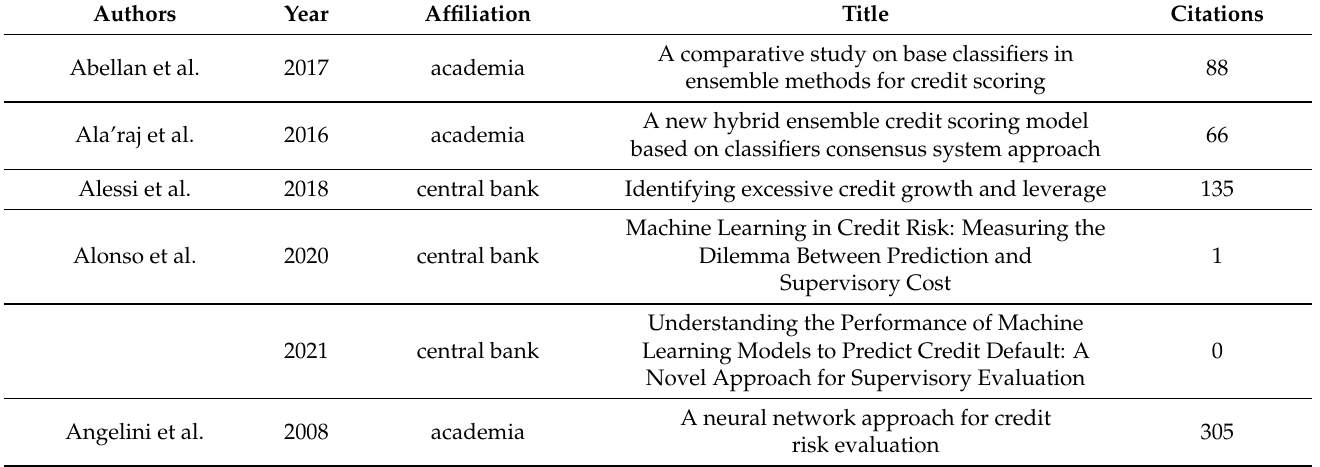
Table 2. List of papers collected through the research query, referenced by author, year of publication, affiliation, and number of